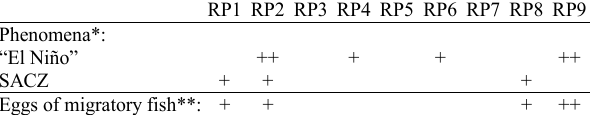
Table 4. Climatic phenomena present during the reproductive periods (RP) at the Ligeiro River from October 2001 to March 2010. *Intensity: +: weak; ++: moderate; **Density: +: < 10 eggs/10m 3 ; ++: > 10 eggs/10m 3